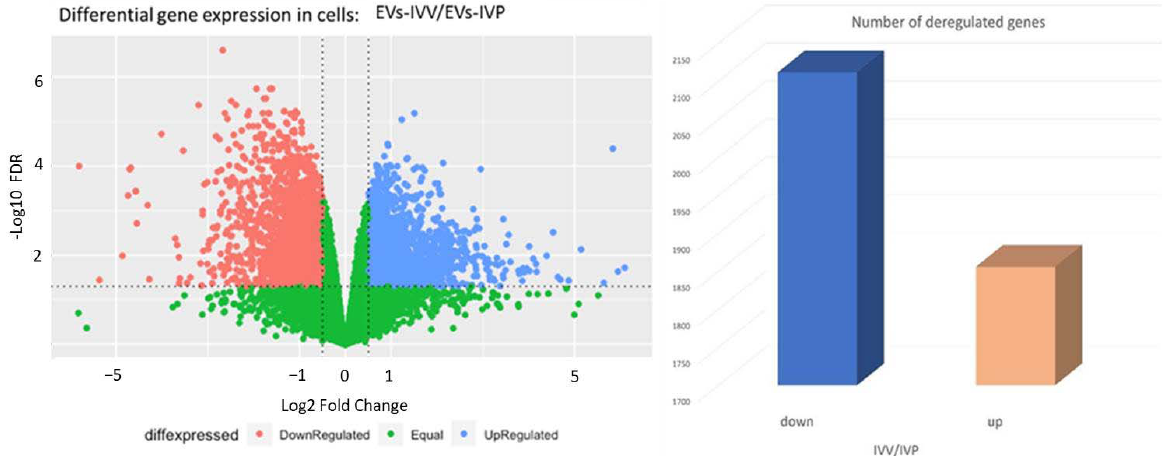
Figure 6. Effect of extracellular vesicles (EVs) secreted by bovine embryos produced in vivo (IVV) or in vitro (IVP) on the gene expression pa tt ern of epithelial endometrial cells.